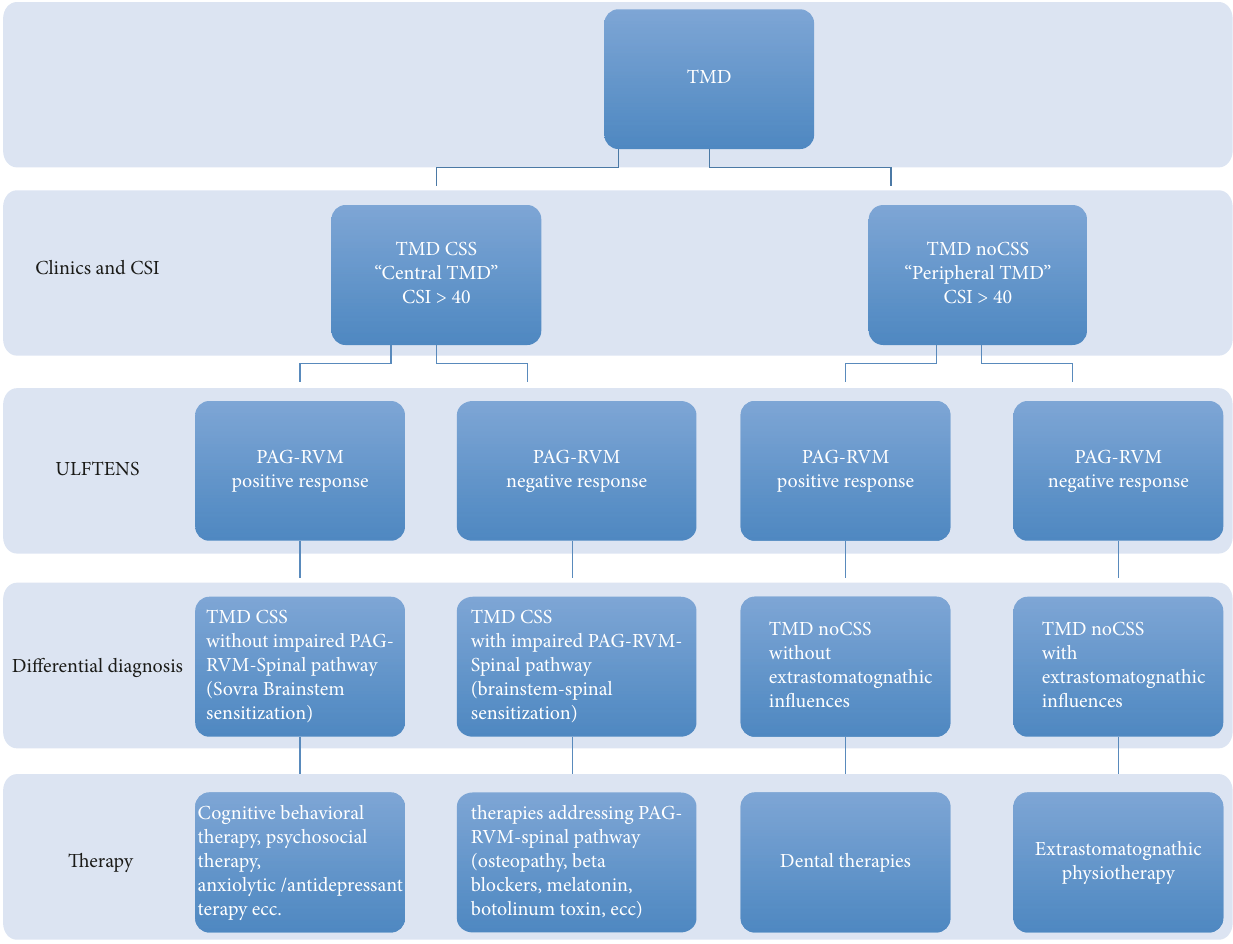
Figure 2: Flow chart for differential diagnosis and therapy based on and response to ULFTENS . CSI: Central Sensitization Inventory, TMD CSS: TMD with Central Sensitization, TMD noCSS: TMD without Central Sensitization, PAG-RVM: Periaqueductal Gray-Rostroventral Medulla.